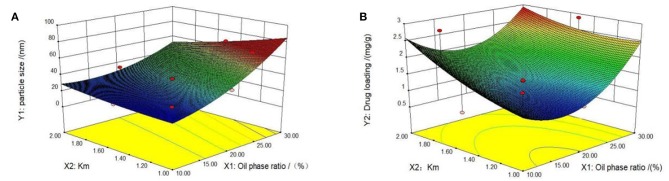
Three-dimensional response surface diagrams. Two influencing factors, oil phase mass ratio and km value, were identified by Design Expert 8.0.6 software. The effect surfaces of three-dimensional curves of particle size and drug loading of the response are shown (A,B). The optimal formulation was determined based on the previous quadratic polynomial fitting equation and response surface diagram.